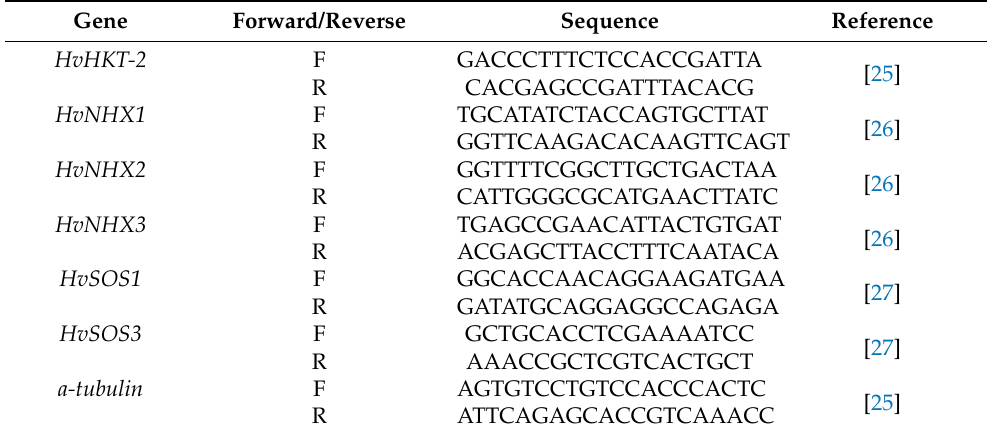
Table 2. The sequences of the used selected salt-tolerance-related genes.